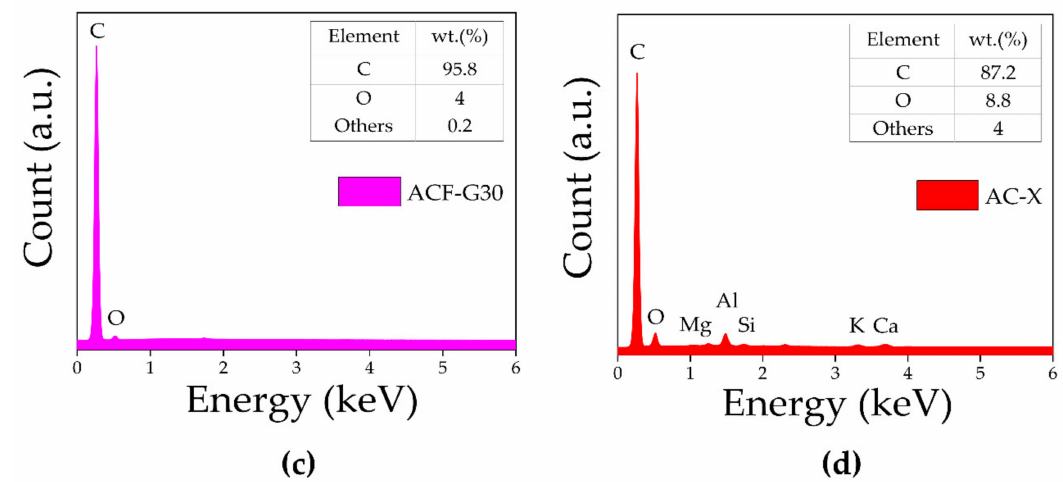
Figure 3. EDX spectra of ( a ) ACF-G10; ( b ) ACF-G20; ( c ) ACF-G30; and ( d ) AC-X.